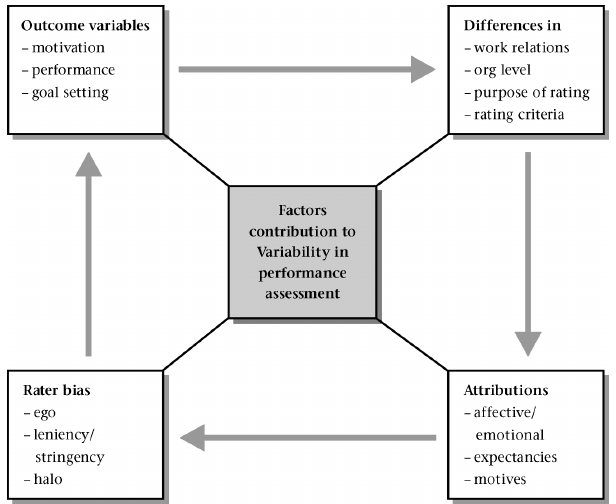
Figure 1: The inter-relationship between possible constructs playing a role in the variability in performance assessment